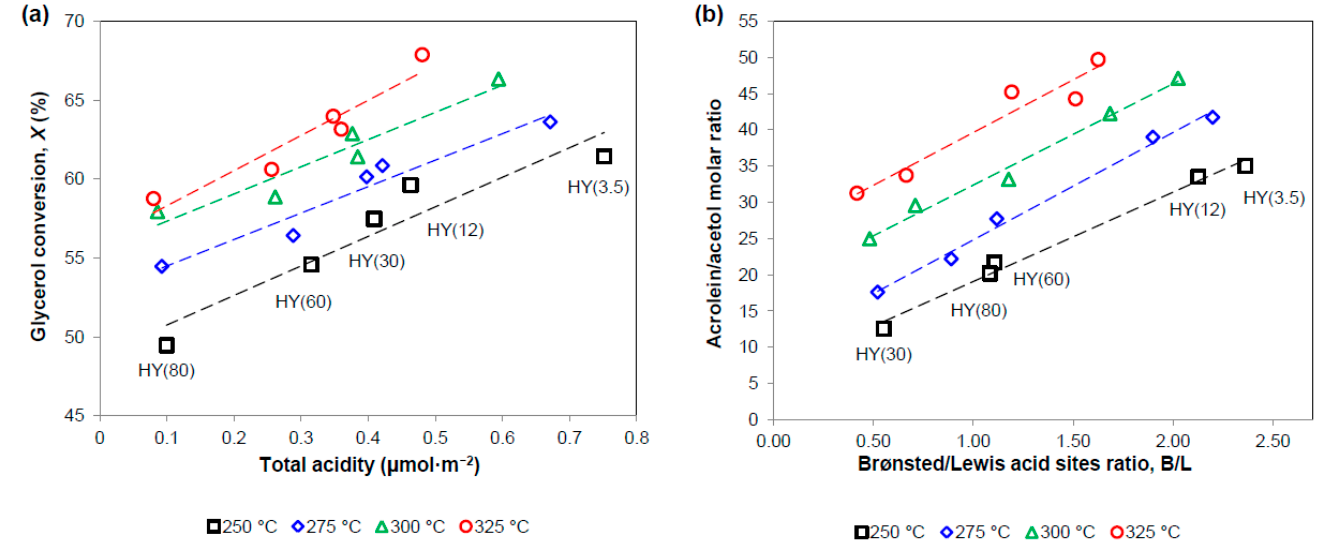
Figure 6. ( a ) Effect of the total acidity on the glycerol conversion and ( b ) effect of the Brønsted/Lewis acid sites ratio on the acrolein/acetol molar ratio.